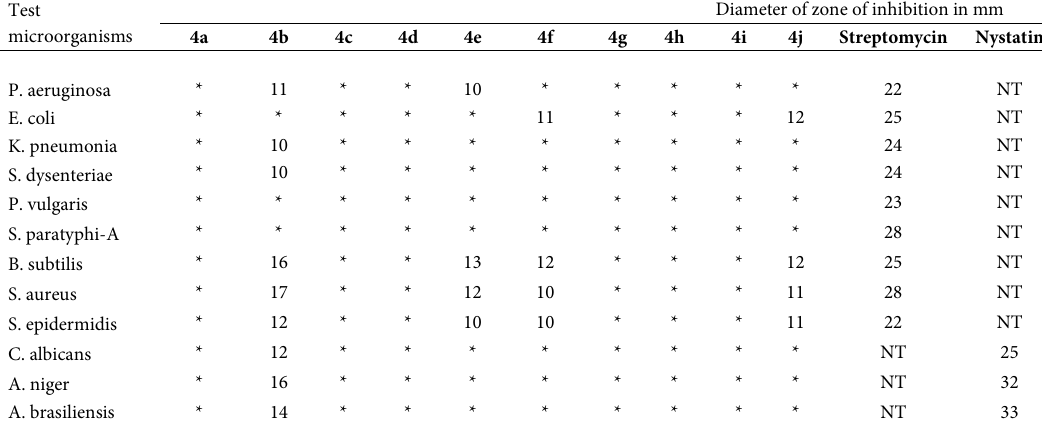
Diameter of zone of inhibition in mm